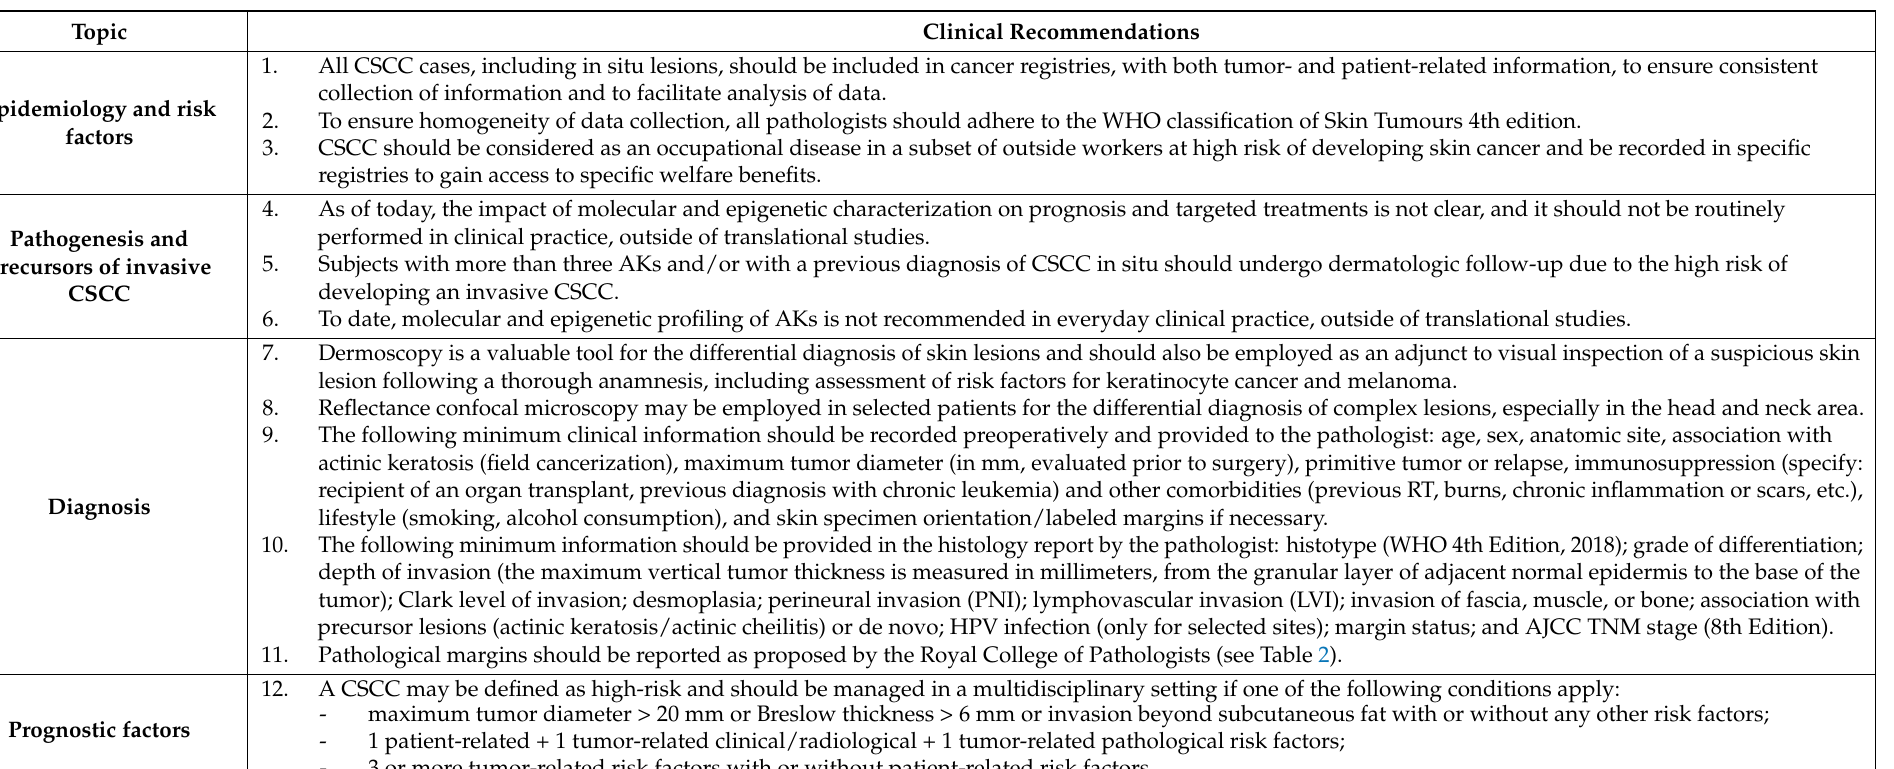
Table 8. Summary of clinical